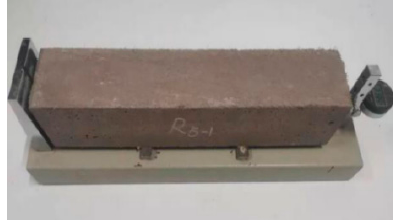
Figure 6. Autogenous shrinkage test.